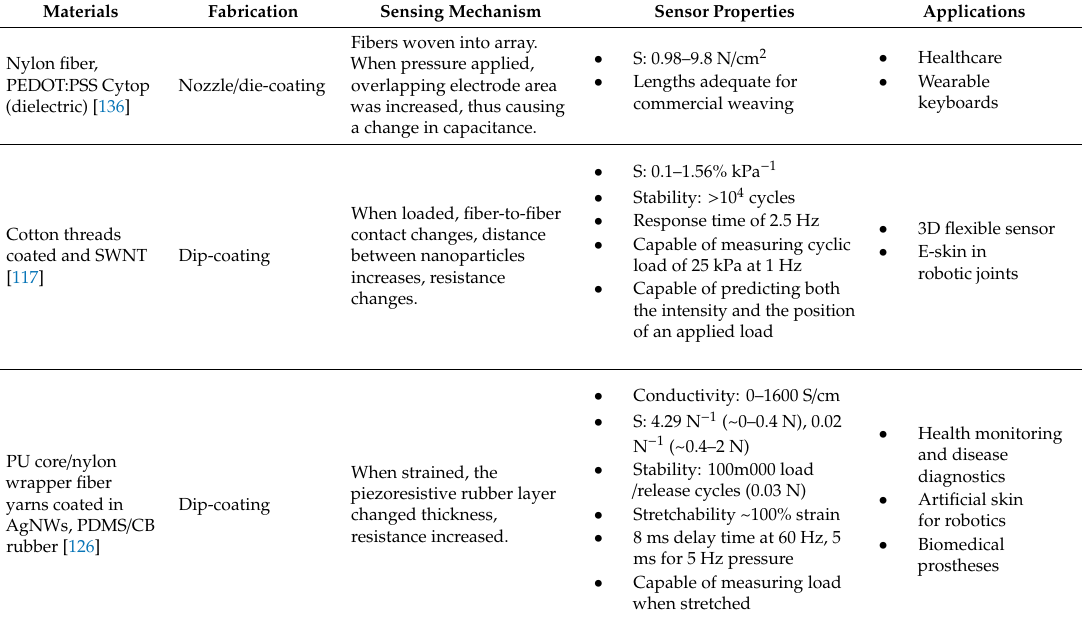
Figure 15. ( a ) 100 m long PEDOT:PSS coated nylon fiber; ( b ) 16 cm × 16 cm fabric array produced with PEDOT:PSS coated nylon fibers; ( c ) demonstration of a sensing 8 × 8 pixel array; ( d ) detected pressure on textile based sensing array. Reprinted with permission from [136]. Copyright 2012 Elsevier B.V.: Amsterdam, The Netherlands. Fiber-based pressure sensors coated with intrinsically conducting polymers and carbonaceous materials. Fabrication Sensing Mechanism Sensor